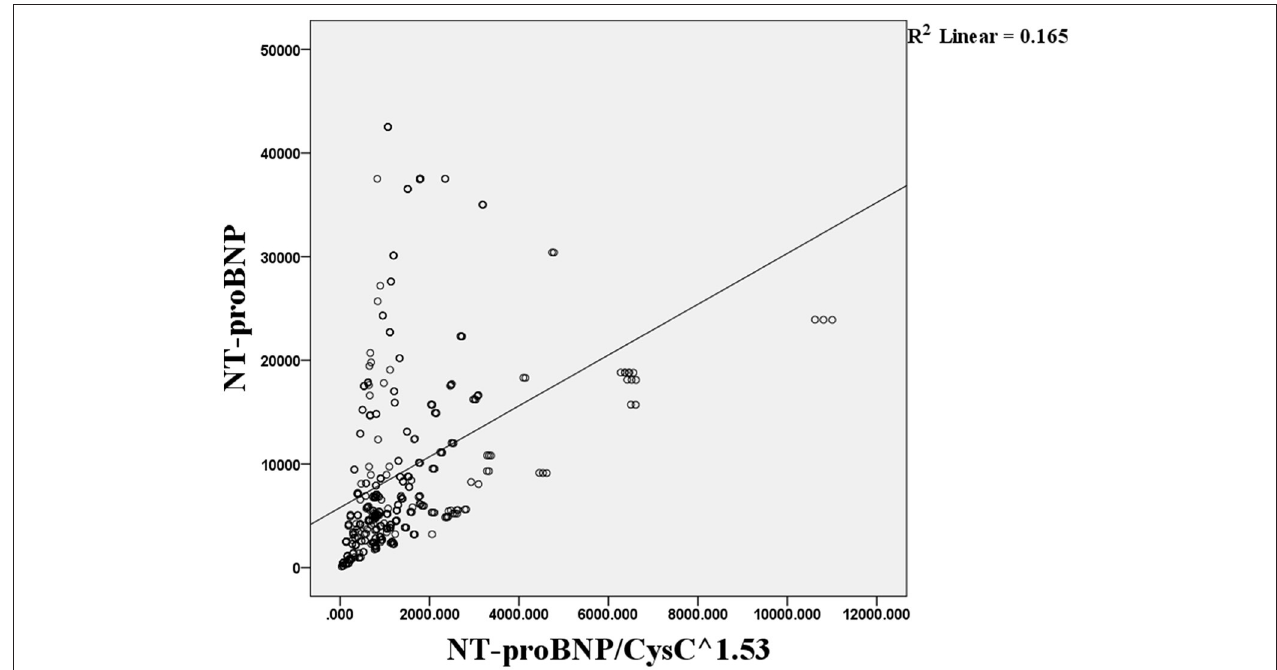
FIGURE 1 | Pearson correlation analysis of the association between the NT-proBNP level and NT-proBNP/CysC 1.53 ratio.